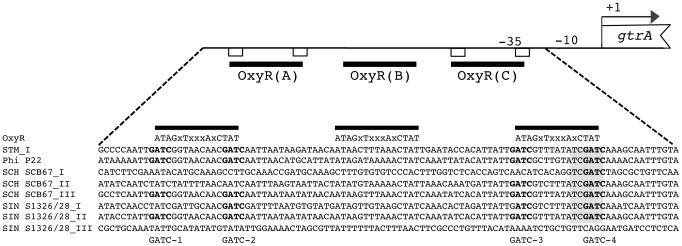
Regulatory regions from 8gtr operons illustrating degrees of conservation and variation in gtr phase variation sequence elements
[20]
. Top of the figure is a schematic representation of the phase variable gtr regulatory region showing the location of three OxyR dimer binding sequences (thick black line), GATC sequences (open rectangle), −35 and −10 promoter sequences, transcription start site (+1) and the gtrA open reading frame. The presence of these elements is a signature of gtr phase variation. Below the schematic is an alignment of seven gtr regulatory region sequences showing consensus OxyR dimer binding sequence, GATC sequences in bold and the −35 of the promoter shaded in grey. Sequence “SIN S1326/28_III” is shown as comparison to illustrate lack of phase variation sequence elements. This sequence was aligned based on conserved sequence surrounding the +1 site (not shown). Acronyms represented: STM, S. Typhimurium; SCH, S. Choleraesuis; SIN, S. Infantis. Figure S1 shows the alignment and conserved nucleotides of 128 bp of regulatory sequence from 43 gtr operons.